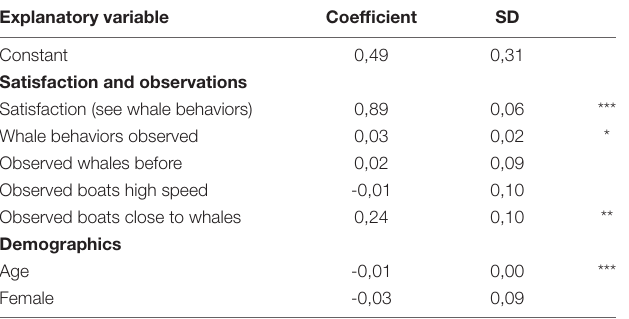
TABLE 4 | Regression results: Factors influencing tourist